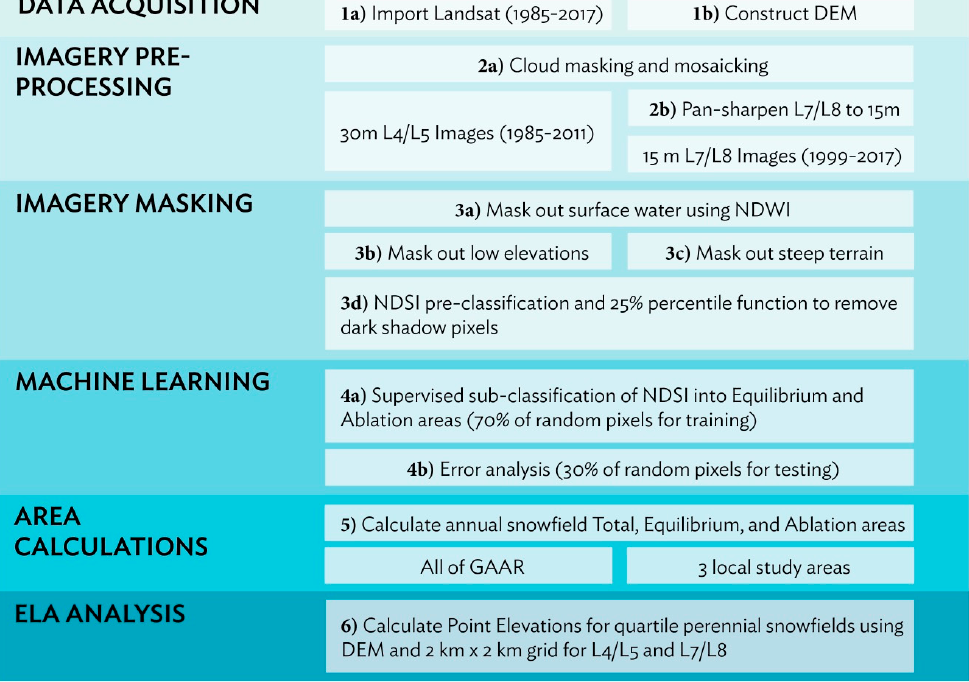
Figure 3. Schematic Flow chart of methodology used in the study. 1a ) Pre-processed Landsat data from missions 4, 5, 7, and 8, for summer (1 July to 15 August) in GAAR were acquired from GEE. 1b ) 5 m DEM was constructed from ArcticDEM and IfSAR data. 2a ) Landsat imagery was cloud masked and mosaicked to obtain one imager per summer. 2b ) Mosaicked Landsat 7 and 8 datasets were pan-sharpened to 15 m scale with pan-chromatic band and HSV technique. 3a ) Non-snow land cover types were masked out, including surface water using NDWI, 3b ) elevations below 900 m to eliminate aufeis, and 3c ) very steep terrain that cannot hold snow with slope angles over 55 degrees. 3d ) Remaining image evaluated using NDSI and 25% darkest pixels (shadows) removed using a percentile function. 4a ) NDSI areas sub-classified into ablation and equilibrium areas using supervised classification and 4b ) error analysis. 5 ) Snowfield areas calculated annually for total, equilibrium, and ablation areas, across GAAR and in three local study areas. 6 ) Lowest Point Elevations (PEs) calculated using DEM and 2 km 2 grid for each snowfield area remaining stable for at least four years .